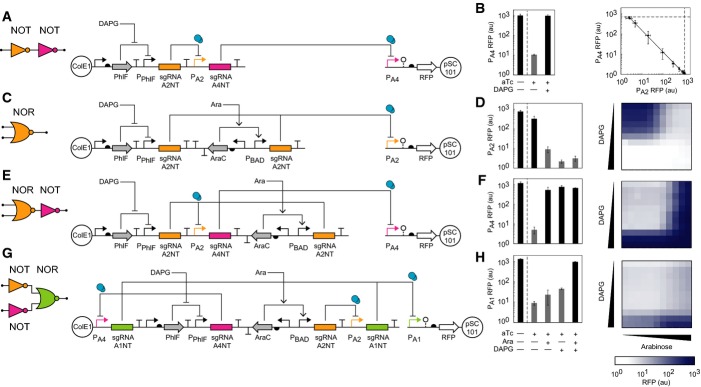
Design and characterization of synthetic circuitsThe wiring diagram and genetic schematic for a double inverter circuit are shown. The
sgRNA-A2NT/PA2 pair is shown in orange, the sgRNA-A4NT/PA4 pair is shown in
magenta, dCas9 is shown in blue, positive regulation is indicated by arrows, and negative regulation
is indicated by flat-headed arrows.The digital RFP response of the NOT-NOT gate is shown for the two input inducer states (dCas9
induced with 0.625 ng/ml aTc): no DAPG and 25 μM DAPG. Also shown is the RFP output without
dCas9 induction (leftmost column), which represents the maximum achievable output. Gray columns are
expected to be OFF, and black columns are expected to be ON (left). The trade-off in expression
between the middle and output promoters (PA2 and PA4, respectively) is shown
for intermediate sgRNA induction levels (right). DAPG concentrations from left to right (μM)
are the following: 0, 2.42, 3.39, 4.74, 6.64, 9.30, 13.0, 18.2, 25.5, 35.7, and 50. Dashed lines are
uninduced dCas9 control experiments and represent the maximum output for each promoter. Error bars
represent the standard deviation of three independent experiments on different days.The wiring diagram and genetic schematic for a NOR(A,B) gate are shown. The
sgRNA-A2NT/PA2 pair is shown in orange, and dCas9 is shown in blue.The NOR gate digital RFP response is shown (left) for the four input inducer states (with dCas9
induced by 0.625 ng/ml aTc): no arabinose or DAPG, arabinose (2 mM), DAPG (25 μM), and
arabinose and DAPG (2 mM and 25 μM). Also shown is the output without dCas9 induction
(leftmost column). In addition, the circuit response to intermediate inducer values is shown to the
right.The wiring diagram and genetic schematic for a layered NOT[NOR(A,B)] gate (i.e. an
OR gate) are shown. The sgRNA-A2NT/PA2 pair is shown in orange, the
sgRNA-A4NT/PA4 pair is shown in magenta, and dCas9 is shown in blue.The OR digital RFP response is shown (left) for five input inducer states (as in D). Intermediate
values are also shown (right).The wiring diagram and genetic schematic for a four sgRNA circuit with
NOR[NOT(A),NOT(B)] functionality (i.e. an AND gate) are shown. The
sgRNA-A2NT/PA2 pair is shown in orange, the sgRNA-A4NT/PA4 pair is shown in
magenta, the sgRNA-A1NT/PA1 pair is shown in green, and dCas9 is shown in blue.The AND gate digital RFP response is shown (left) for five input inducer states (as in D).
Intermediate values are also shown (right). Data information: For graded induction of circuits in (D), (F), and (H), aTc was added to
0.625 ng/ml; arabinose was added to the following final concentrations (mM): 0, 0.00391, 0.00781,
0.0156, 0.0313, 0.0625, 0.125, 0.25, 0.5, 1, and 2; 2,4-diacetylphloroglucinol was added to the
following final concentrations (μM): 0, 0.0244, 0.0488, 0.0977, 0.391, 0.781, 1.56, 3.13,
6.25, 12.5, and 25.